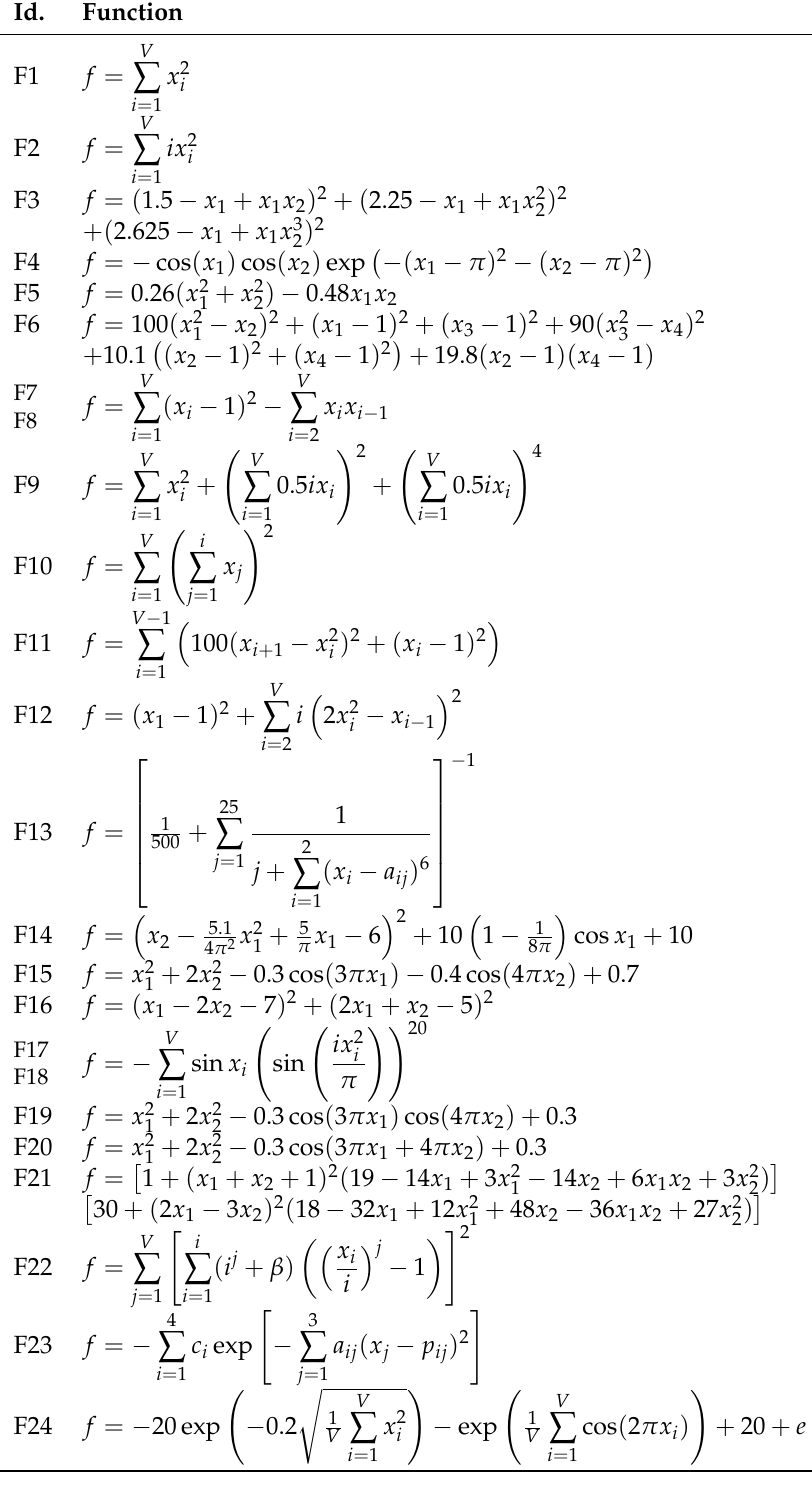
Table 2. Benchmark